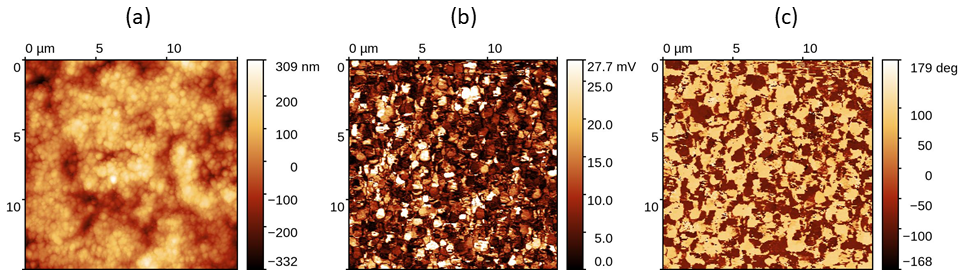
Figure 7. ( a ) Non-contact AFM topography image of TMCM-MnCl 3 film, 15 µ m × 15 µ m. PFM amplitude ( b ) and phase ( c ) images of TMCM-MnCl 3 film, 15 µ m × 15 µ